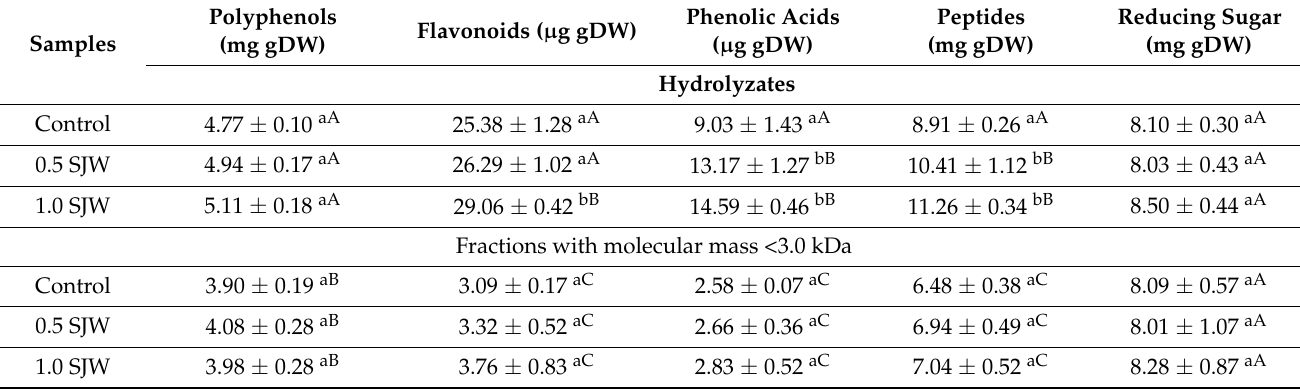
Table 2. Bioactive compounds in hydrolyzates and fractions with molecular mass <3.0